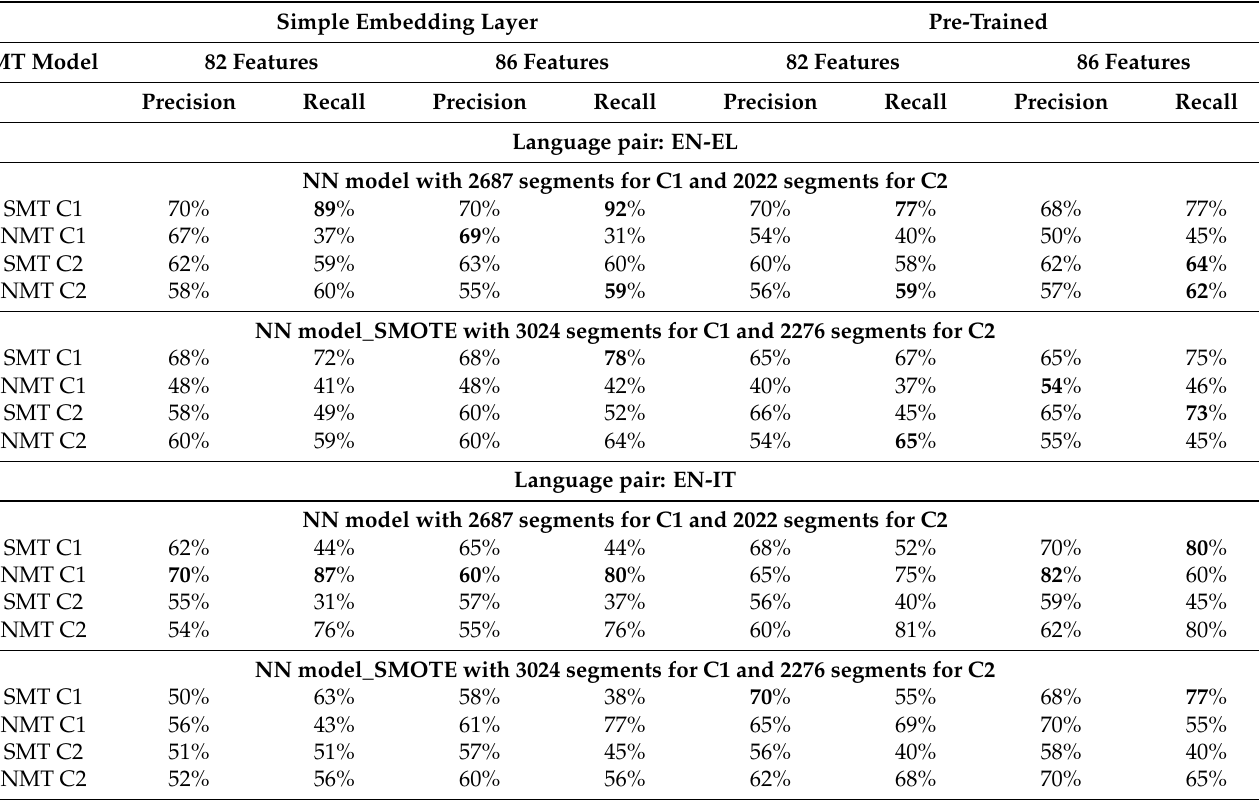
Table 2. Accuracy performance for two embeddings layer types for the two corpus English–Greek (EN–EL)/English–Italian